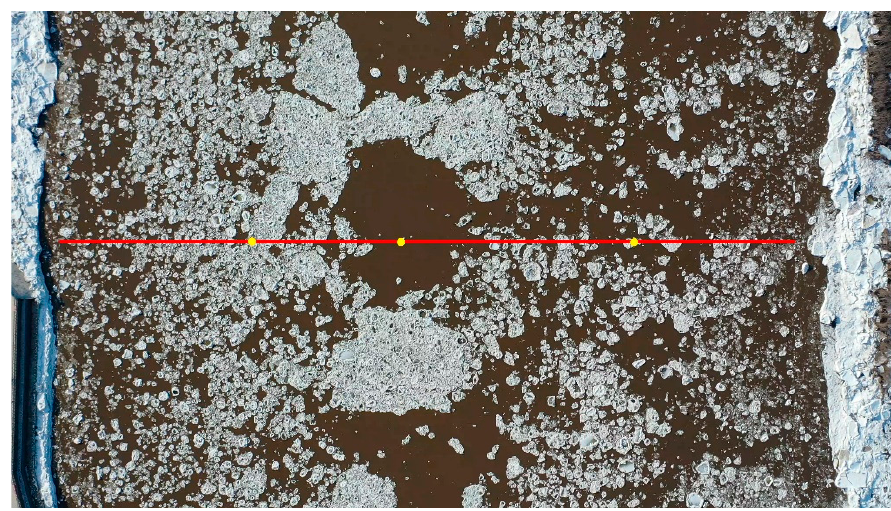
Figure 12. Characteristic points on transverse section of the river channel.